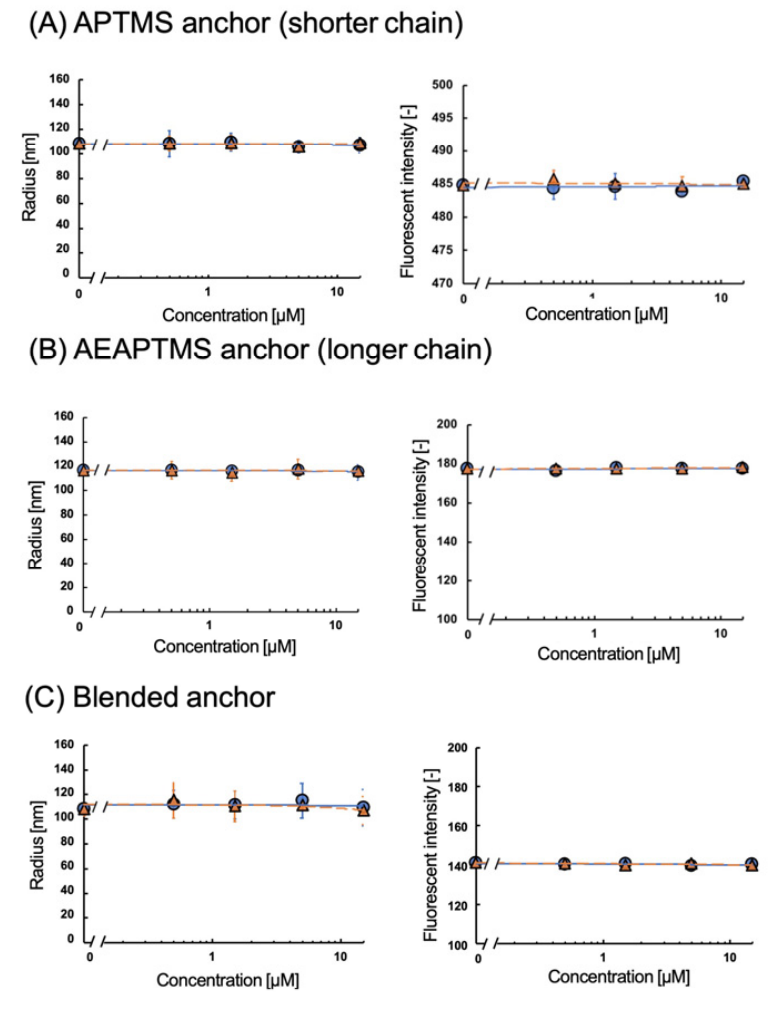
Figure 4. Effect of the 5 − HT (circles) and Trp (triangles) on the radius ( left ) and fluorescent intensity ( right ) of the fNIP-NP synthesized at the glass beads coated with ( A ) APTMS, ( B ) AEAPTMS, or ( C ) their blend